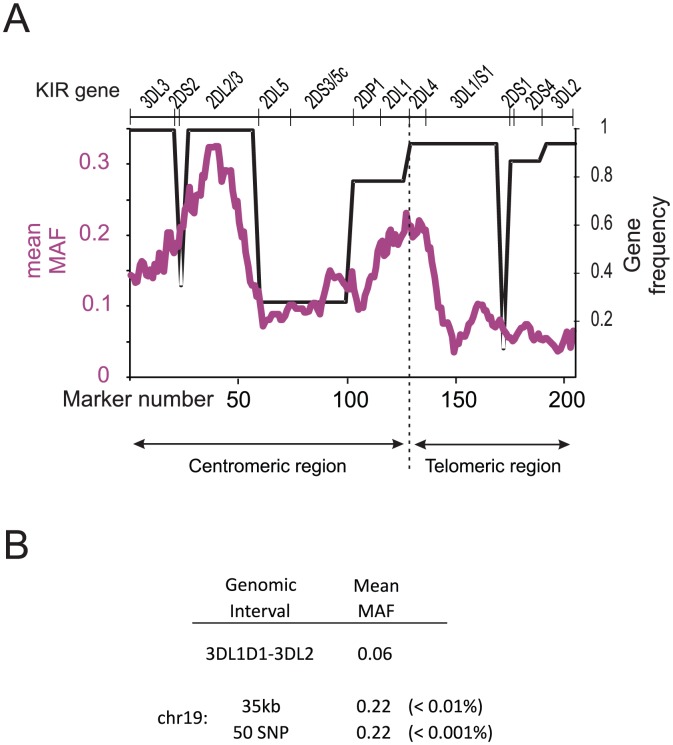
Low diversity of the KIR locus begins after KIR3DL1/S1 D0.A. Mean minimum allele frequency (MAF) for sliding windows of 15×1 markers throughout the KIR locus in Ga-Adangbe (purple line). The black line shows the KIR gene frequencies. B. Shows the mean MAF of the interval post KIR3DL1-D0 (3DL1D1-3DL2; markers 150–200 in panel A) compared with equivalent intervals by size (35 kb) or SNP number (50 SNPs) generated from a sliding-window analysis of Yoruba chromosome 19 data [96]. The percentile that includes the 3DL1D1-3DL2 value is shown in brackets.